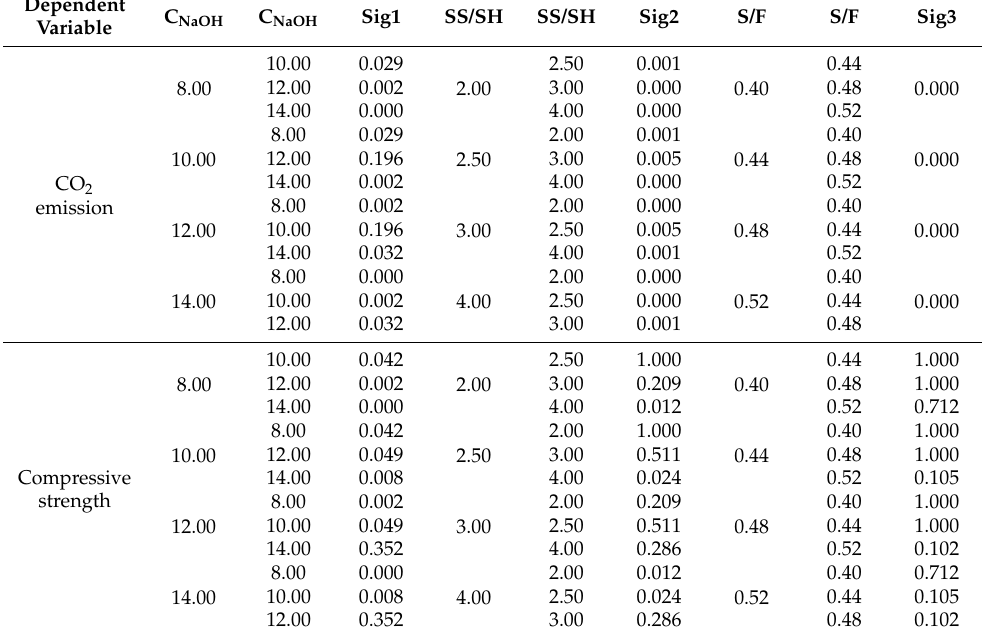
Table 6. Bonferroni analysis simplified results on SPSS